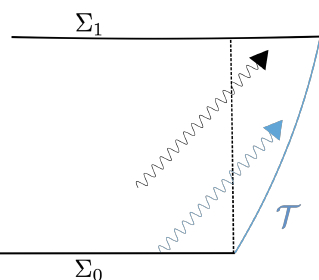
Figure 2 . If the time-like hypersurface at which the boundary conditions are imposed is tilted with respect to the time-like evolution of the corner of Σ , symplectic flux can a priori leak through it, as in the top (and darker) arrow. In that case, the procedure to get integrable charges applies only to the ‘barred observers’, namely those at rest with respect to a foliation of T